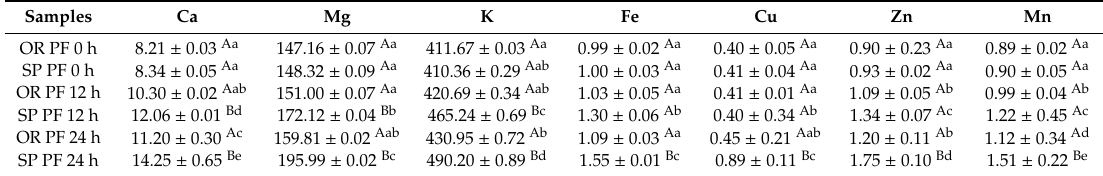
Table 6. Mineral content of SP PF and OR PF mu ffi